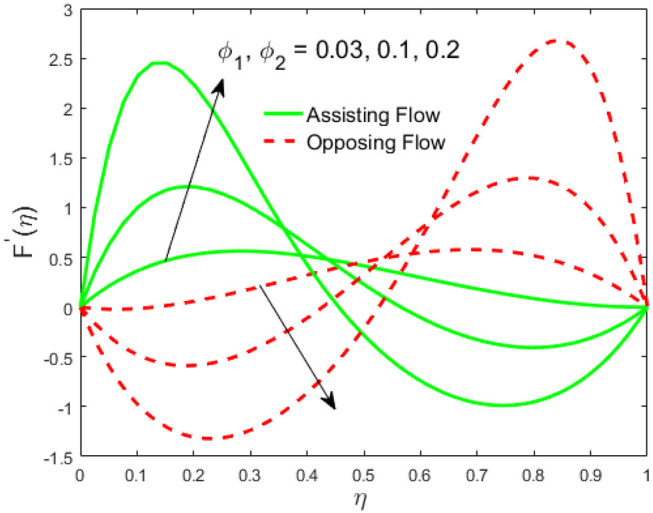
Impact of ϕ1, ϕ2 on F′(η).